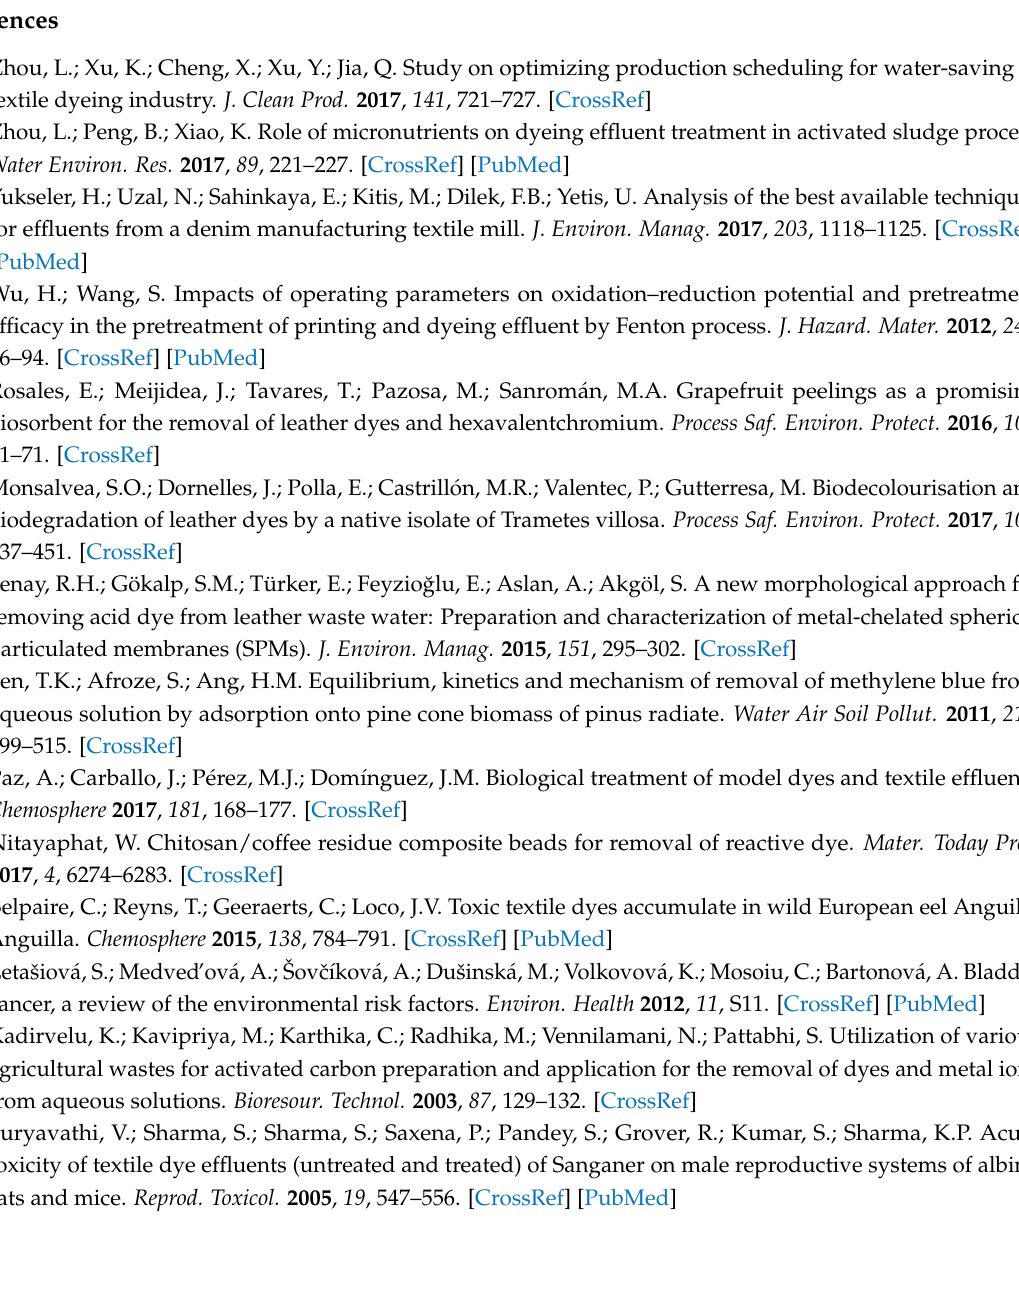
s1: Figure S1: FTIR analysis on chitosan, β -chitosan crosslinked with triethylenetetramine, and its intermediate products; Figure S2: 13 C solid-state NMR of chitosan and β -chitosan crosslinked with triethylenetetramine; Table S1: Characterization of the functional groups on the adsorbent before and after RB221 adsorption, using infrared spectroscopy analysis; and Video S1: Demonstration of the RB221 dye adsorption of BCCT for dye anion before and after